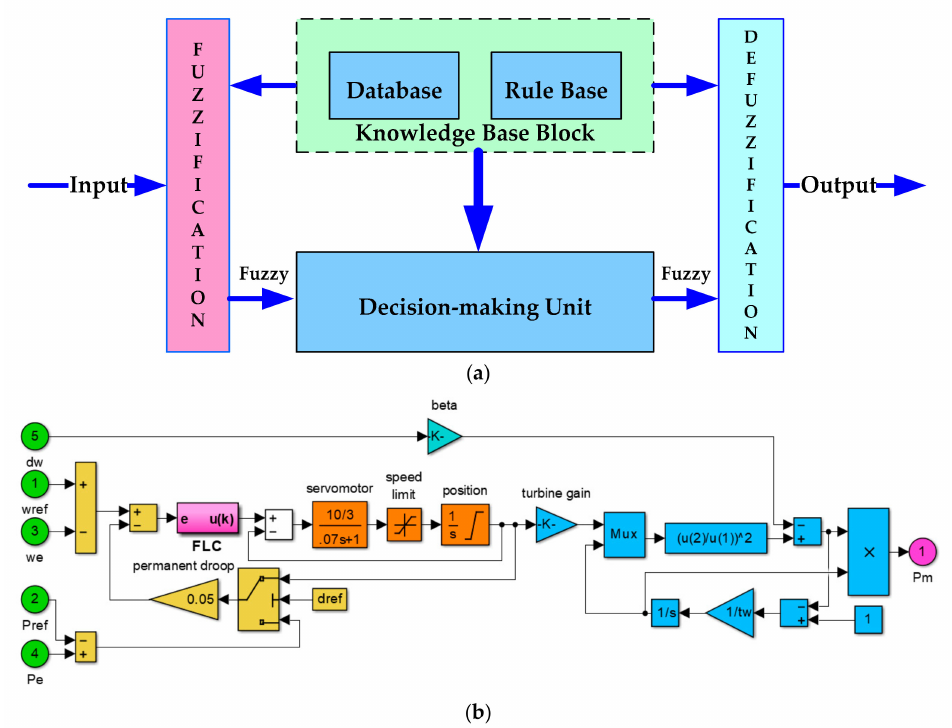
Figure 6. ( a ) Basic configuration of a fuzzy logic control; ( b ) fuzzy logic based turbine control